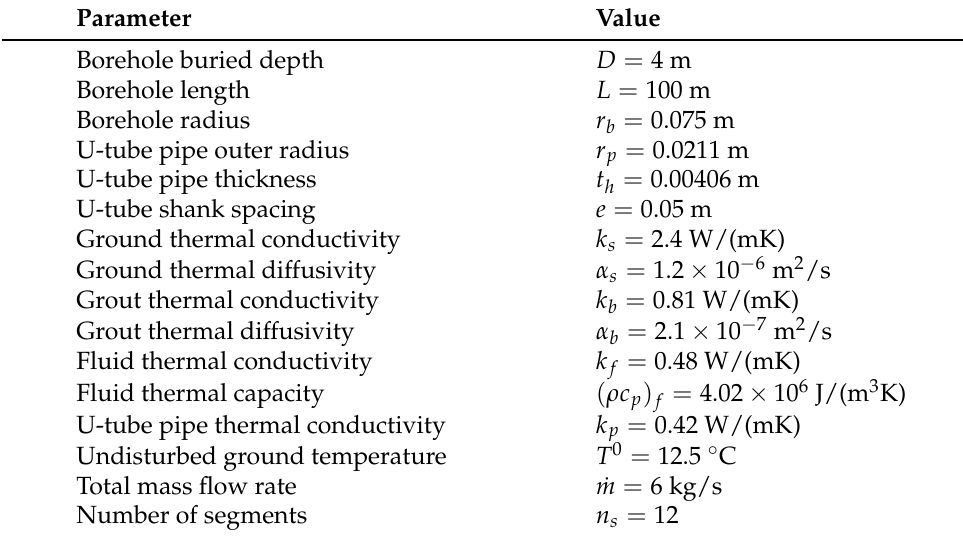
Table 2. Borefield parameters.